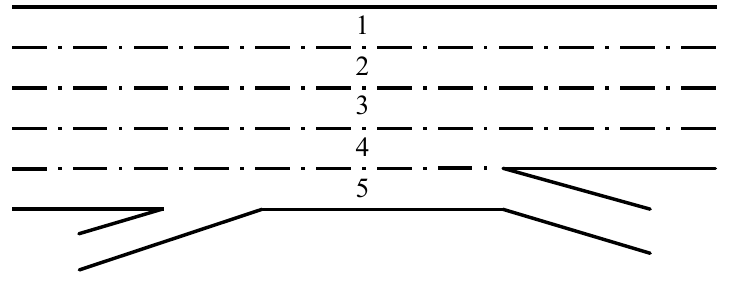
Figure 1. Lane setting of US101 collection section.